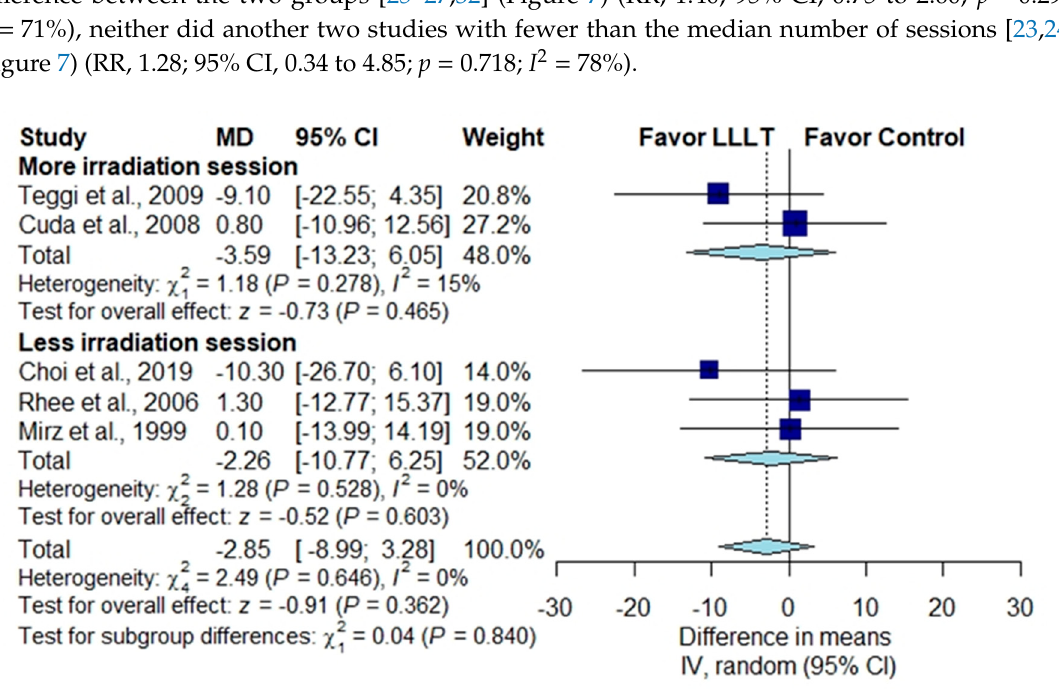
Figure 7. Subgroup analysis of rating scale score improvement rates according to the number of irradiation sessions [23–26,29,31] . 3.3.5. Subgroup Analysis According to Wavelength Setting Three studies used a wavelength setting of 830 nm, and the pooled effect estimate demonstrated no significant difference between the LLLT group and the placebo group [1,30,31] (Figure 8) (MD, − 2.26; 95% CI, − 10.77 to 6.25; p = 0.362; I 2 = 0%); similarly, two studies with a wavelength setting of 650 nm showed no significant difference between the two groups [28,29] (Figure 8) (MD, − 3.59; 95% CI, − 13.23 to 6.05; p = 0.465; I 2 = 15%).